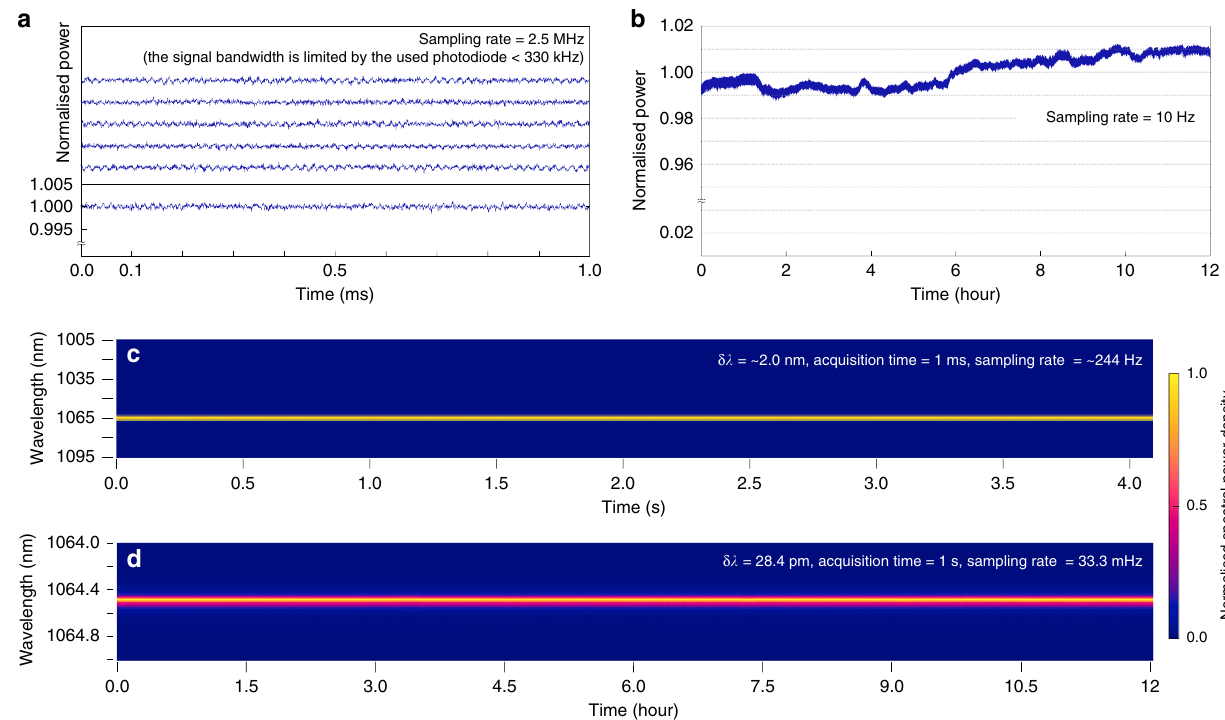
Fig. 4 Temporal properties. The short- ( a ) and long-term ( b ) temporal dynamics of laser power. The measured power is normalized to its mean value. All measurements in the Fig. 4a are identically scaled. The short- ( c ) and long-term ( d ) temporal dynamics of the laser spectrum. The measured spectral power density is normalized to the maximum value of the entire series. See ‘ Methods ’ for the details of the measurement setup.